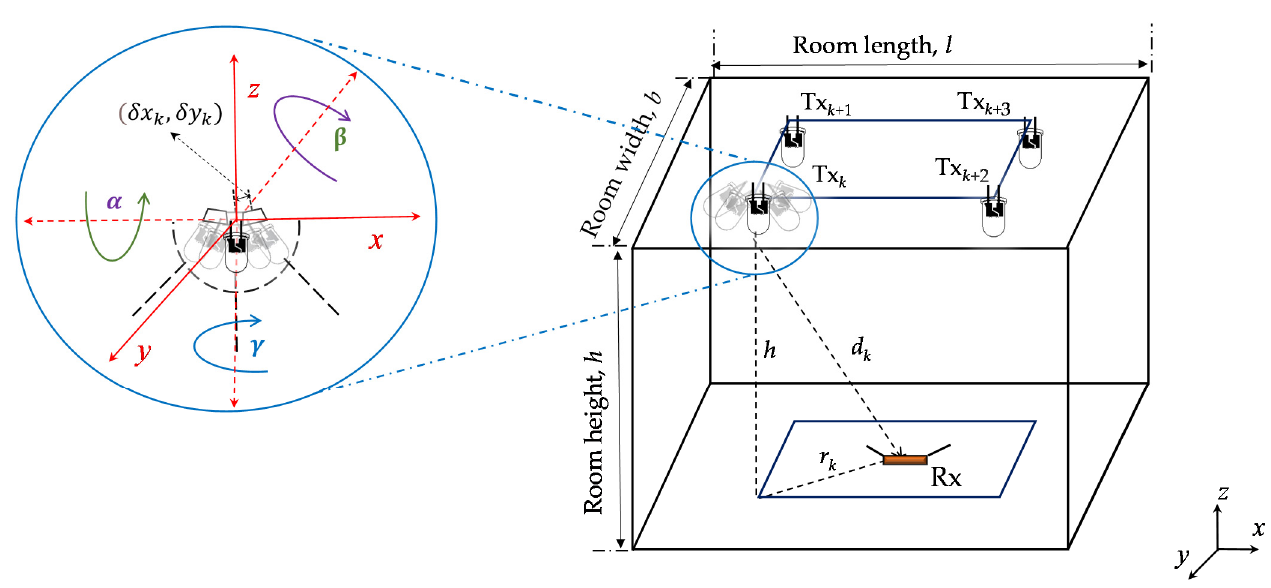
Figure 1. Overview of the simulation set-up.